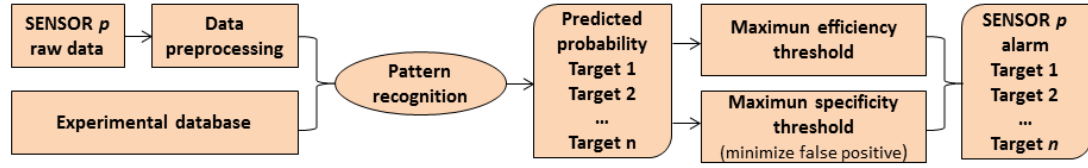
Figure 2. Scheme of the expert system step for pattern recognition at sensor level.